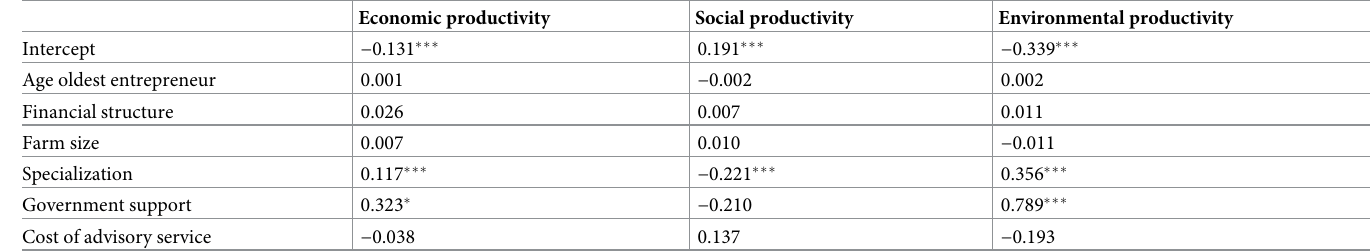
Table 3. OLS bootstrap regression results of economic, social and environmental sustainability productivity growth and its